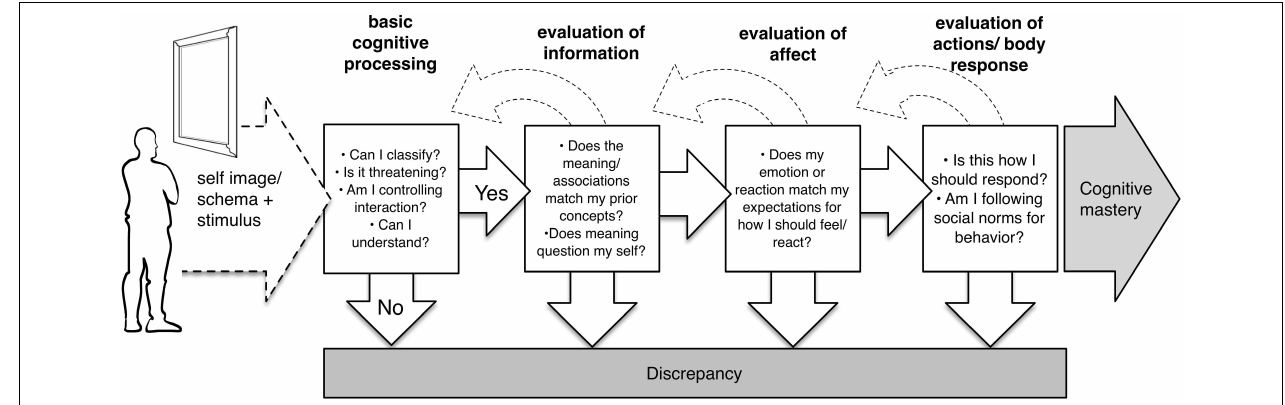
FIGURE 3 | Varieties of assessment that may lead to discrepancy within the cognitive mastery